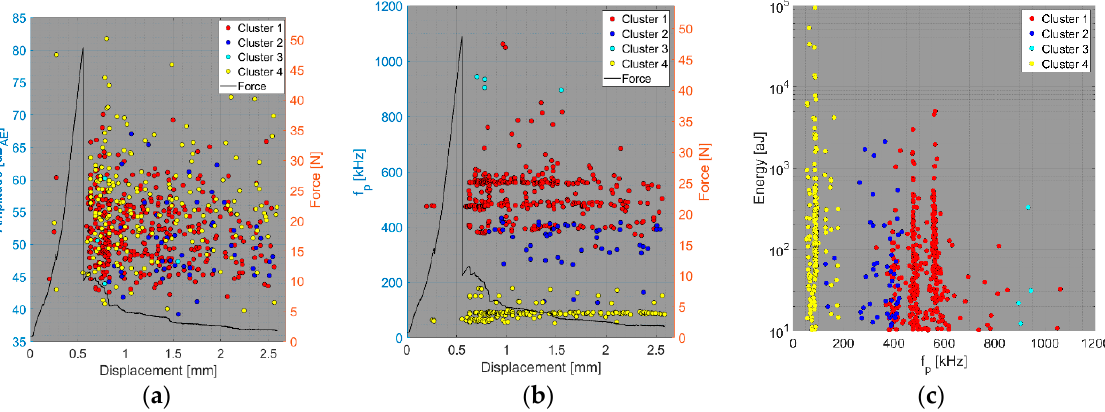
Figure 15. Clustering results for a UCT representative sample using a spectral clustering algorithm and secondary filtering using a partial power variable (Fujicera 1045S dataset).